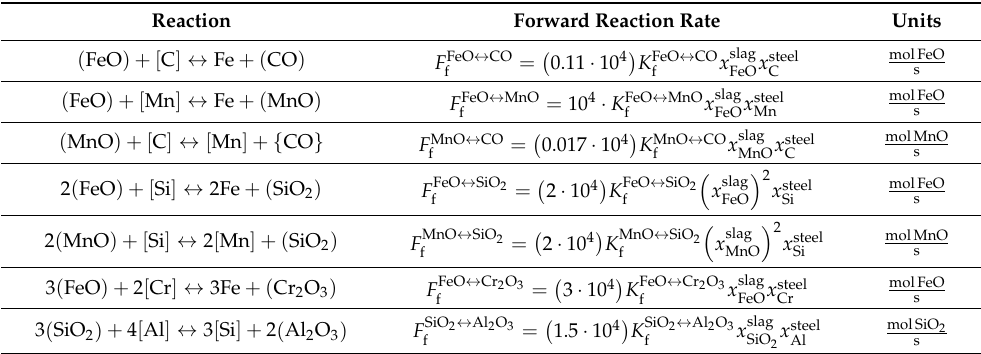
Table A3. Forward reaction rates for equilibrium reactions. x denotes mass fractions and k f refers to kinetic model constants for each reaction.